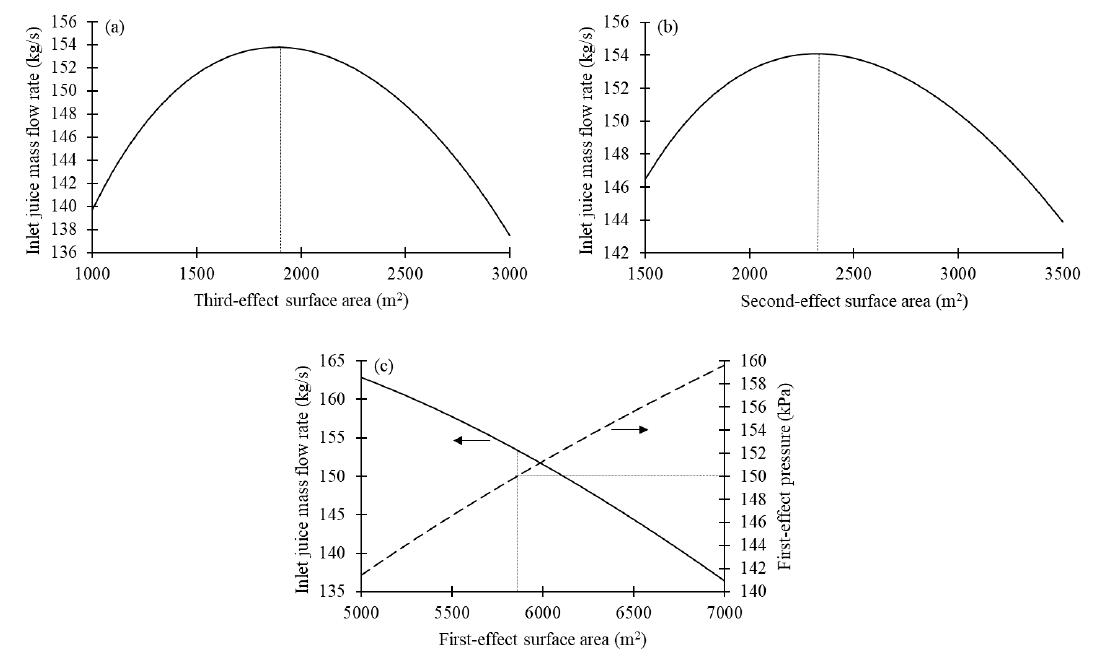
Figure4. Procedure for finding theoptimum surface area distribution in theforward-feed multiple-e ff ect Figure 4. Procedure for finding the optimum surface area distribution in the forward - feed multiple - evaporator: ( a ) finding the optimum third-e ff ect surface area ( A 3 ), ( b ) finding the optimum second-e ff ect effect evaporator : ( a ) finding the optimum third - effect surface area ( A 3 ) , ( b ) finding the optimum surface area ( A 2 ), and ( c ) finding the first-e ff ect surface area ( A 1 ) corresponding to the first-e ff ect second - effect surface area ( A 2 ) , and ( c ) finding the first - effect surface area ( A 1 ) corresponding to the pressure ( p 1 ) of 150 first - effect pressure ( p 1 ) of 150 kPa .